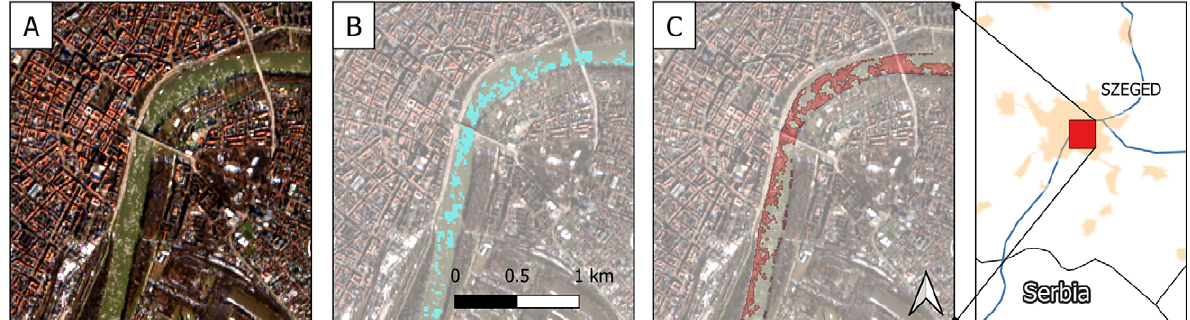
Figure 10. Validation of ice coverage derived from Sentinel-1 in 2022 on the Tisza. Validation satellite image (Sentinel-2 RGB843) (A), reference data derived by ISODATA clustering of Sentinel-2 image (B), and ice coverage derived from